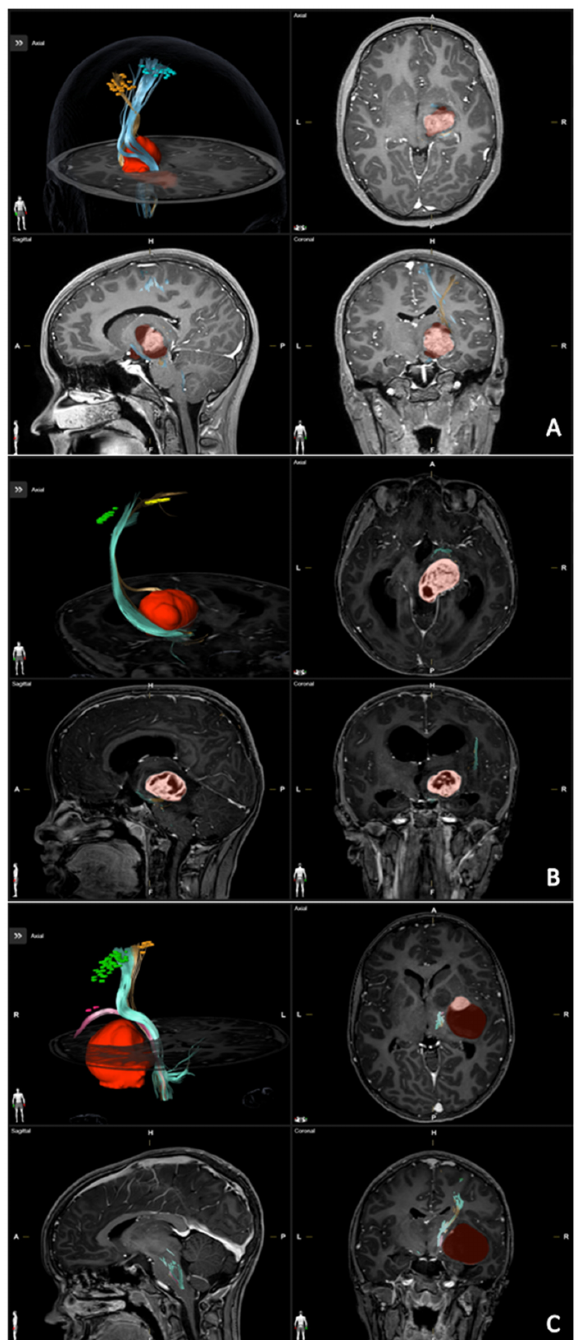
Figure 2. ( A ) Patient n. 1: right thalamopeduncular glioma causing a lateral displacement of CST with hand bundle splayed anteriorly (orange) and bundle for leg posteriorly. ( B ) Patient n. 2: right thalamopeduncular glioma with secondary hydrocephalus causing anterior displacement of the hand bundle (yellow) and the leg bundle posterolaterally. ( C ) Patient n. 3: right thalamic glioma leading to a medial displacement of the CST with bundle for mouth markedly shifted anteriorly (violet); hand (green) and leg (yellow) bundles